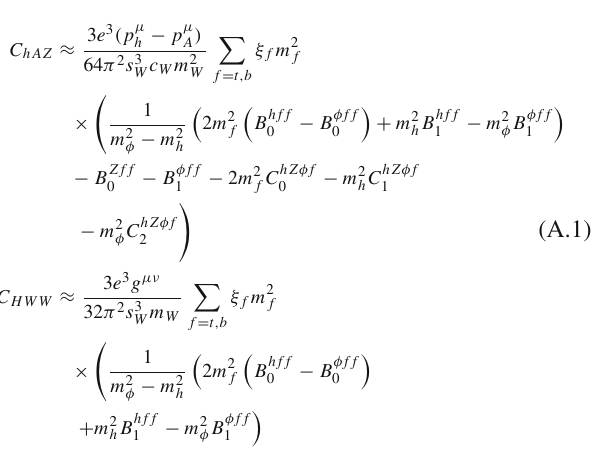
F 2HDM. The grey background represents the points with Γ A or Γ H larger than the values described in Sect. 2.4, with three black lines for Γ A = 10%, 20%, and